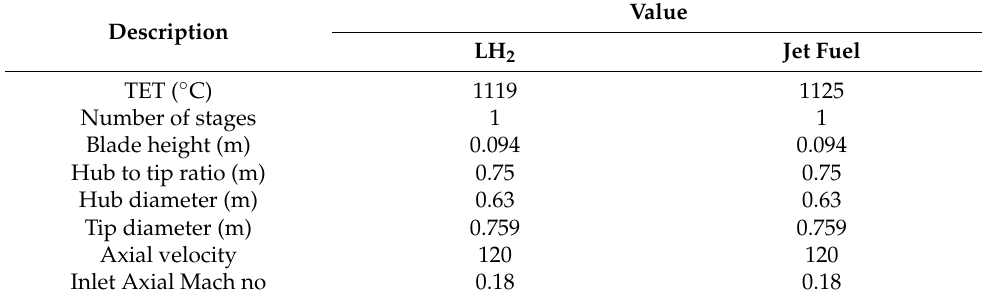
Table 4. HPT geometry and